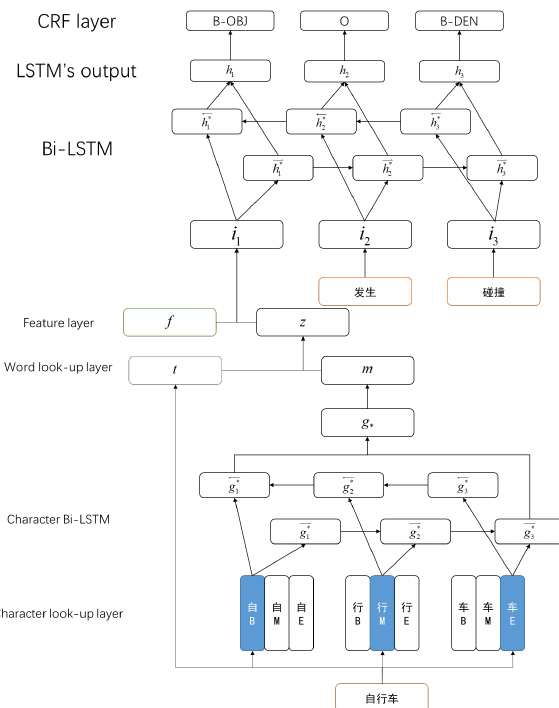
Figure 1. The architecture for the event trigger and argument recognition in the event